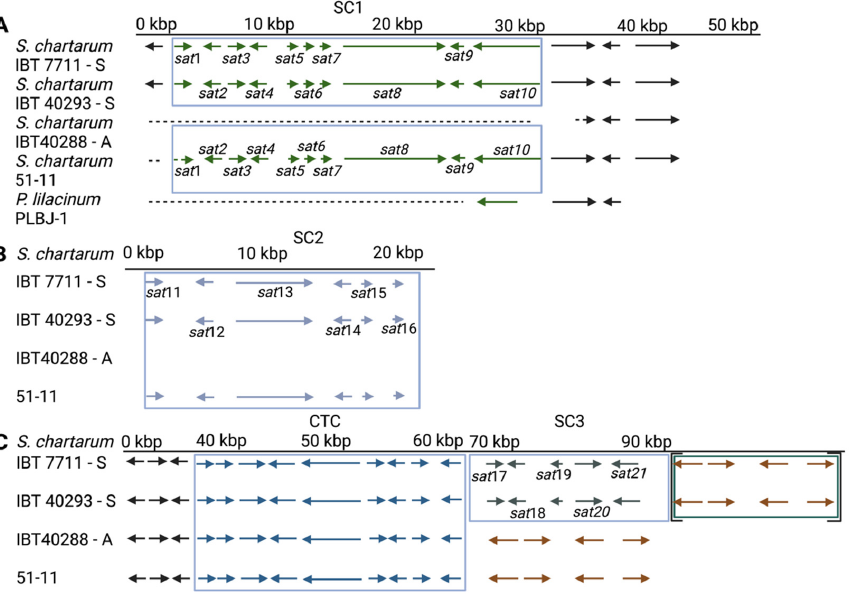
Figure 1. Satratoxin clusters 1–3 (SC1-3, ( A – C )) and the core trichothecene cluster (CTC) of S. chartarum strains 51-11, IBT 40293, IBT 7711 (genotype S strains), and IBT 40288 (genotype A strain). Arrows depict genes; the different gene clusters are boxed. A dotted line indicates that a sequence is not existent in the respective genome. The genes in square brackets (Panel C ) are annotated to a different scaffold than the other genes of these strains, but our PCR and sequencing results demonstrate for IBT 40293 that these regions are part of a continuous sequence. (Panel A ) also shows a region of three homologous genes of the Purpureocillium lilacinum isolate PLBJ-1 for comparison. The brown arrows in (Panel C ) indicate a set of four genes that are present in all four